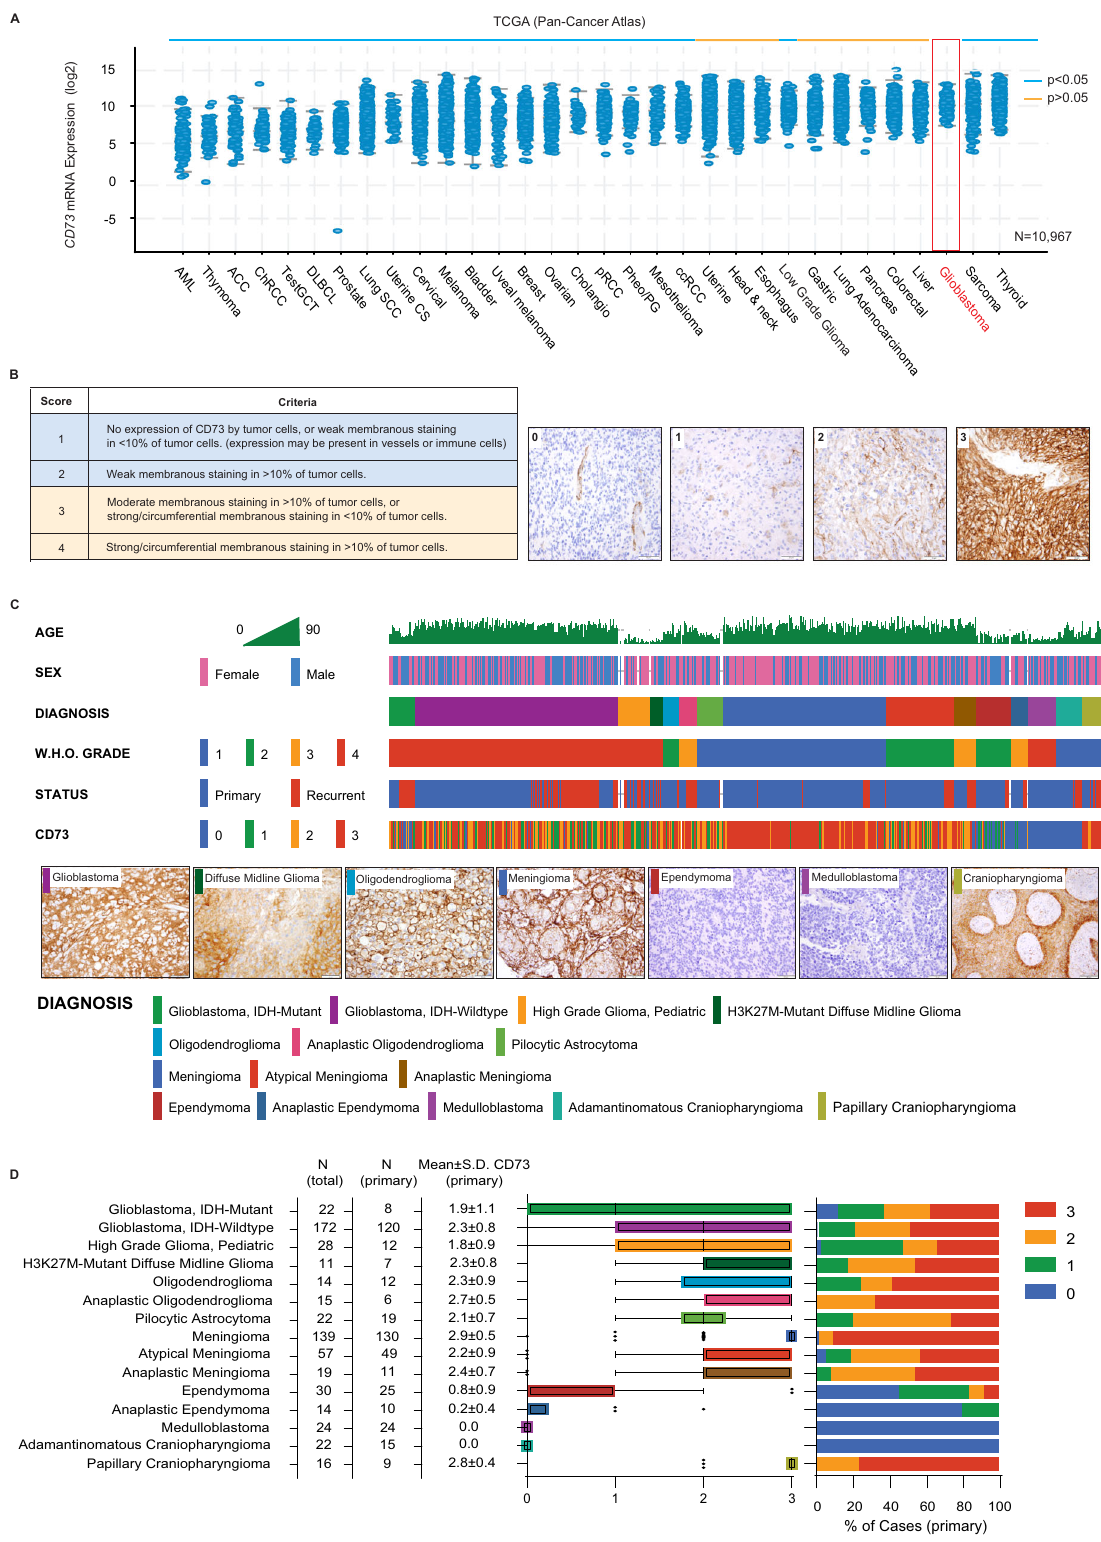
No expression of CD73 by tumor cells, or weak membranous staining in <10% of tumor cells. (expression may be present in vessels or immune cells) Weak membranous staining in >10% of tumor